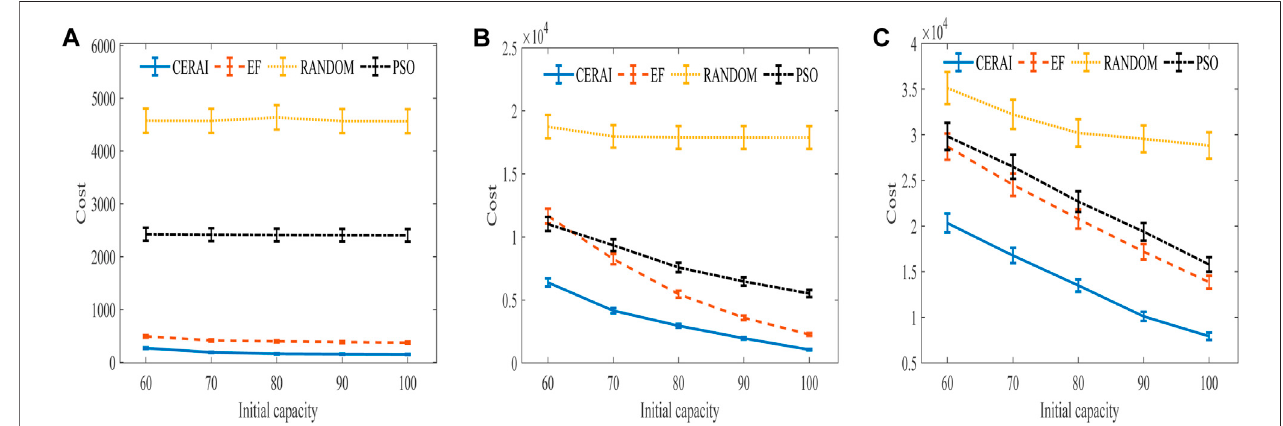
FIGURE 6 | Experimental results of the impact of demanding amount on cost with private cloud. (A) Experimental results of low intensity group. (B) Experimental results of medium intensity group. (C) Experimental results of high intensity group.